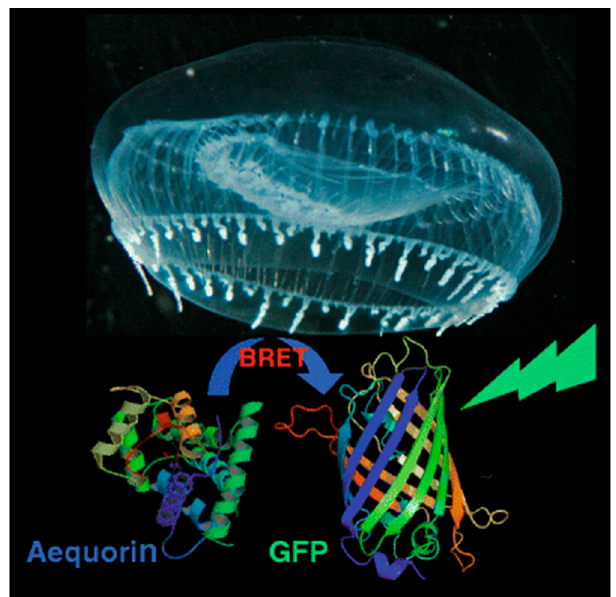
Figure 2. BRET in nature. Both the Ca 2+ -dependent blue-emitting protein aequorin and green fluorescent protein (GFP) are naturally co-localized in rings around the bell of the jellyfish Aequorea victoria . When aequorin is excited in response to a pulse of Ca 2+ flooding the area, the resulting energy can be transferred to nearby GFP, shifting the natural luminescence of the organism from blue to green through BRET. Reproduced with permission from [32]. Copyright 2010 Springer Nature.